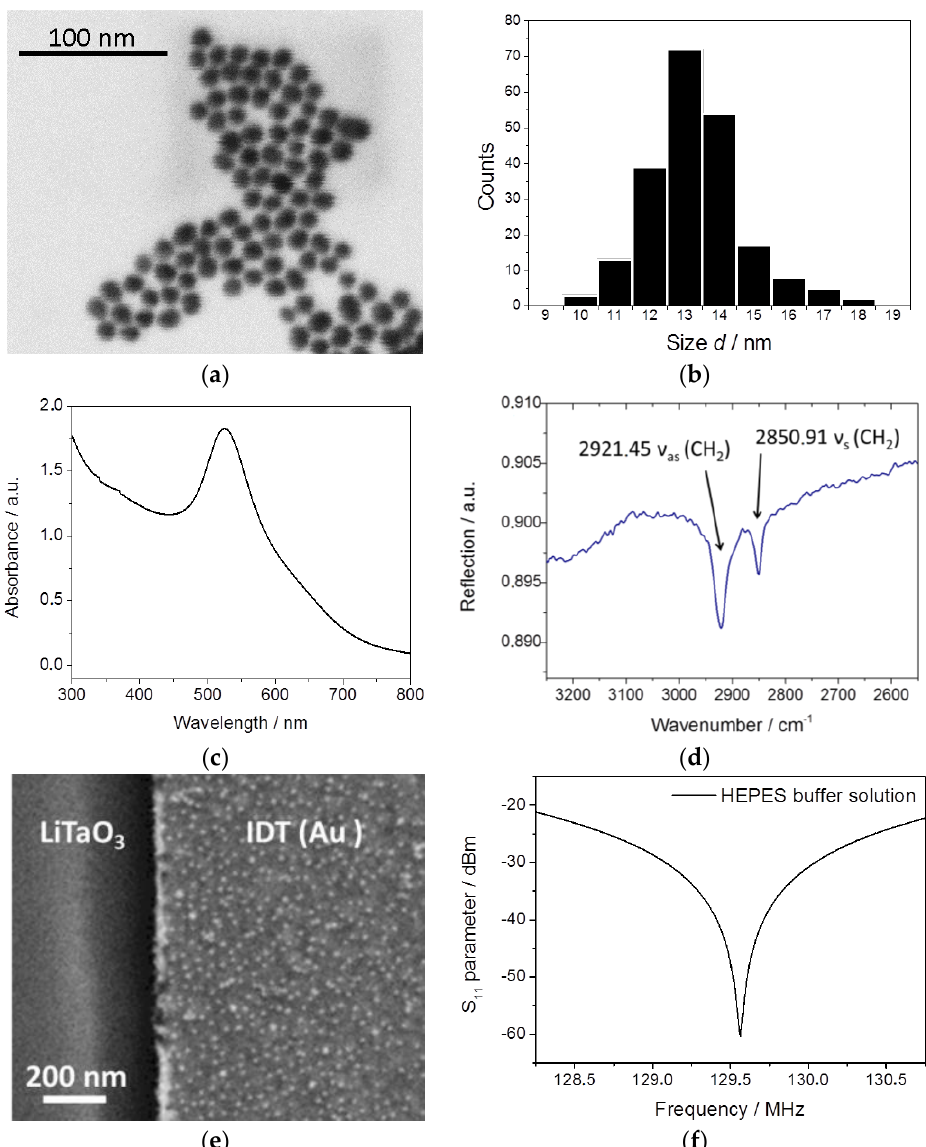
Figure 5. ( a ) Exemplary SEM image of 4-mercaptophenylacetic acid gold nanoparticles (MPA–AuNP); ( b ) Corresponding histogram, revealing spherical particles with a mean size of 13.8 ± 1.8 nm; ( c ) UV-vis spectrum exhibiting the typical plasmon peak at 525 nm for spherical AuNP with an average size of 15 nm; ( d ) FTIR spectrum of a self assembled monolayer (SAM) of 11-amino-1-undecanethiol (AUT) showing the absorption peaks of methyl groups indicating a successful surface modification of IDT; ( e ) SEM picture of MPA–AuNP covered IDT after applying AUT for 24 h and subsequent immersion of the SAW sensor chip in a MPA–AuNP solution for 45 min; ( f ) Measurement of a typical impedance matched S 11 spectrum of an immersed IDT in a HEPES buffer